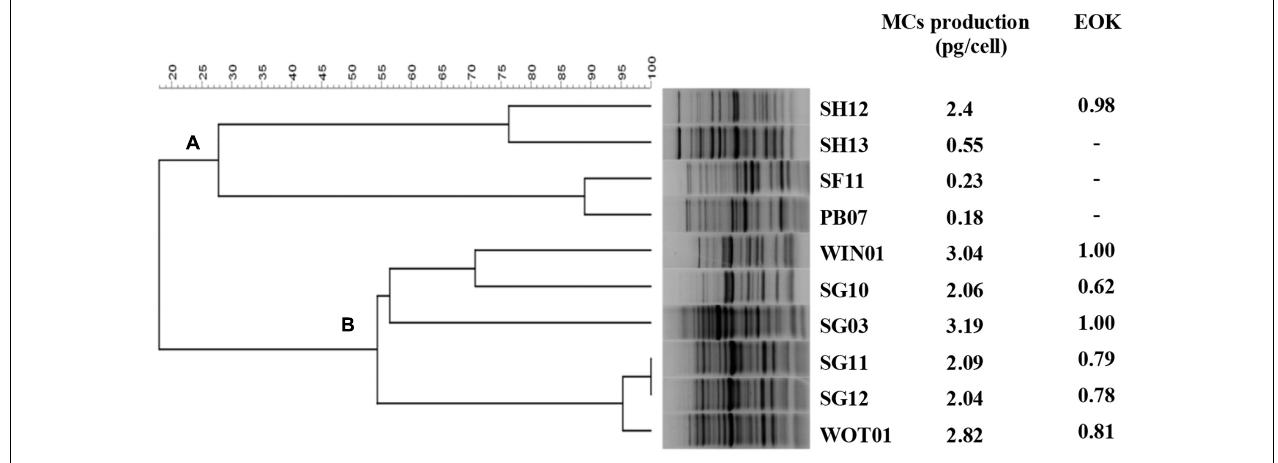
FIGURE 2 | Dendrogram for Microcystis strains created by HIP PCR. HIP PCR was performed in 10 Microcystis isolates, creating 2 groups: (A) and (B) .